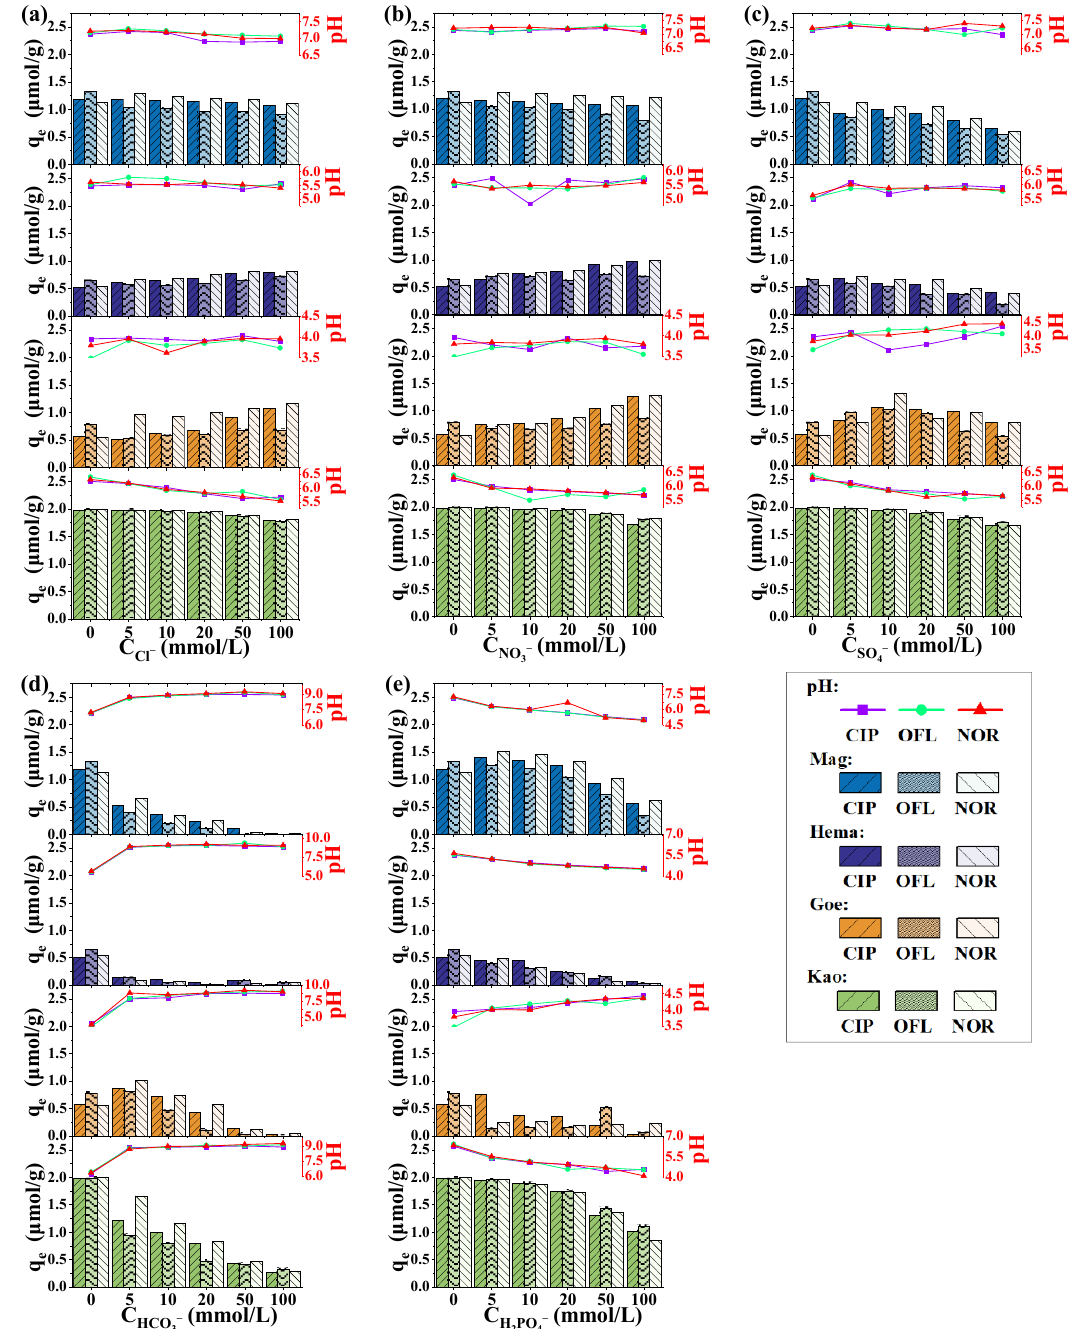
Figure 6. Effect of ( a ) Cl − , ( b ) NO 3 − , ( c ) SO 42 − , ( d ) HCO 3 − , ( e ) H 2 PO 4 − on the adsorption of CIP, OFL and NOR. Bars represent the adsorption amount, and points represent the ending pH of the solution after the adsorption. Conditions: [CIP] 0 = [OFL] 0 = [NOR] 0 = 10 μ mol/L, dosage of solids = 5 g/L.